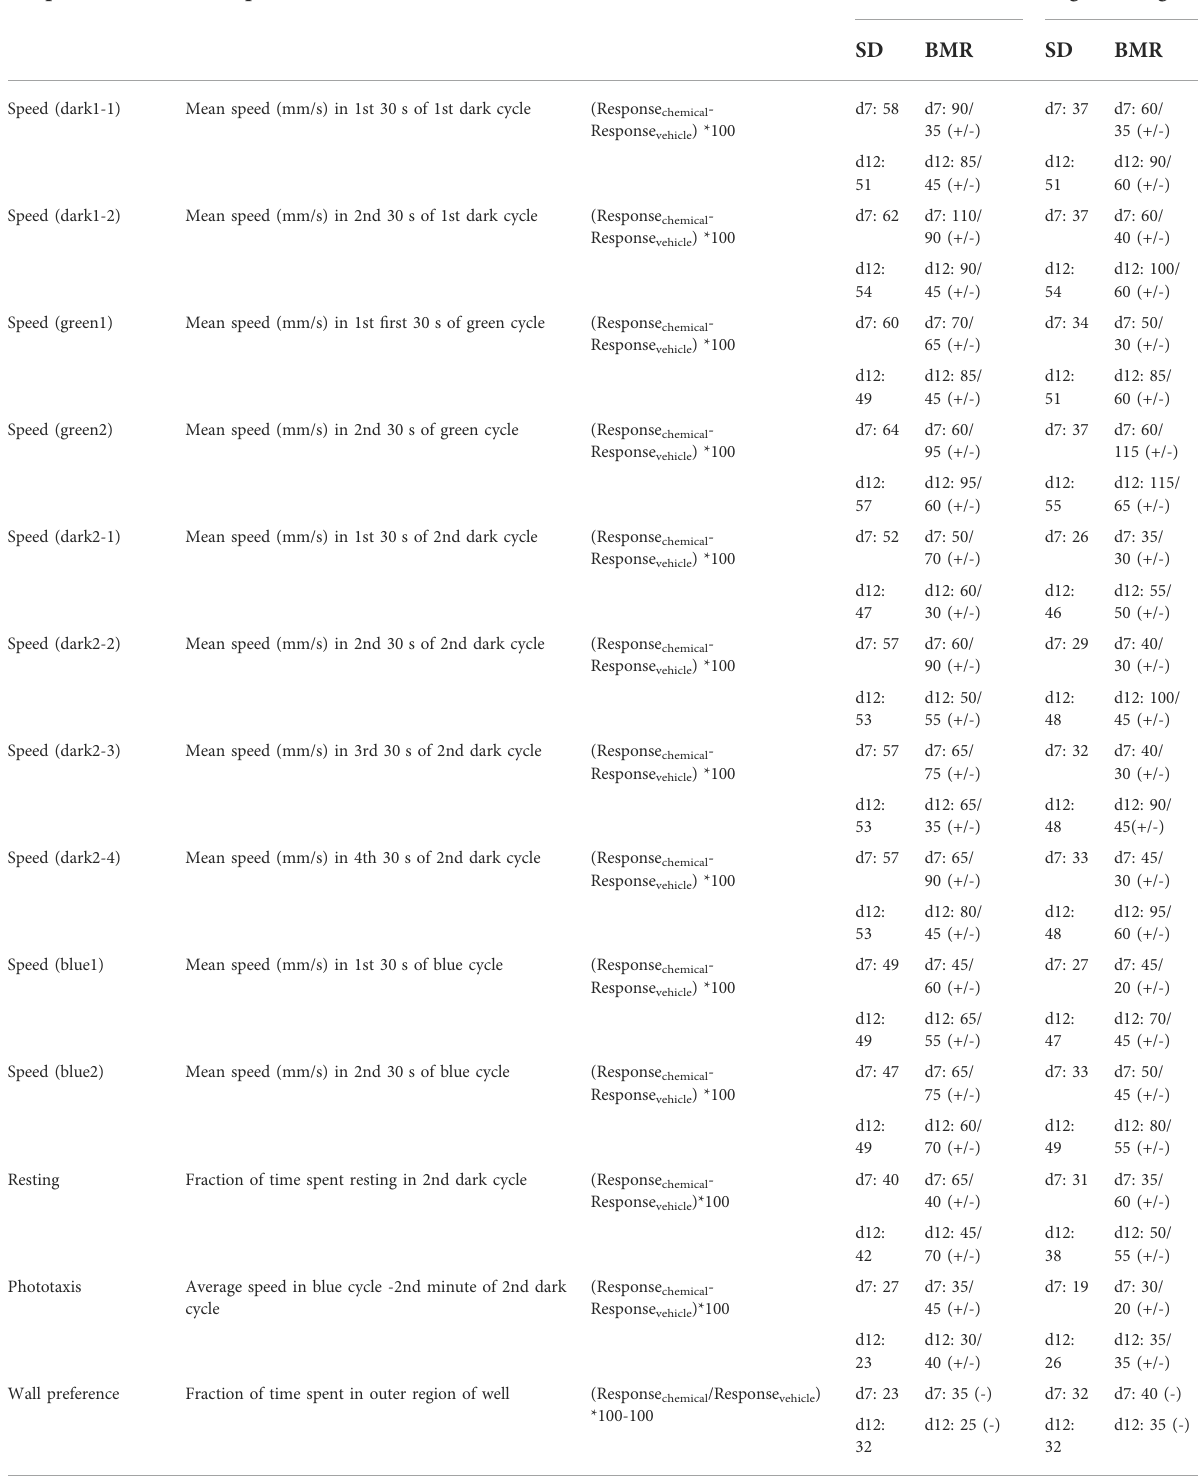
TABLE 3 Continuous endpoints. The standard deviation (SD) of the normalized response in the vehicle controls and benchmark response (BMR) are comparedforeachendpointonday7(d7)andday12(d12).Someendpointscanhaveeffectsinboththepositiveandnegativedirections.Inthese cases, the BMRs for each direction (increasing (+) or decreasing (-)) are